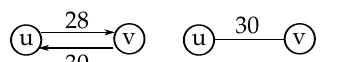
Figure 4. Neighbour broadcast message format